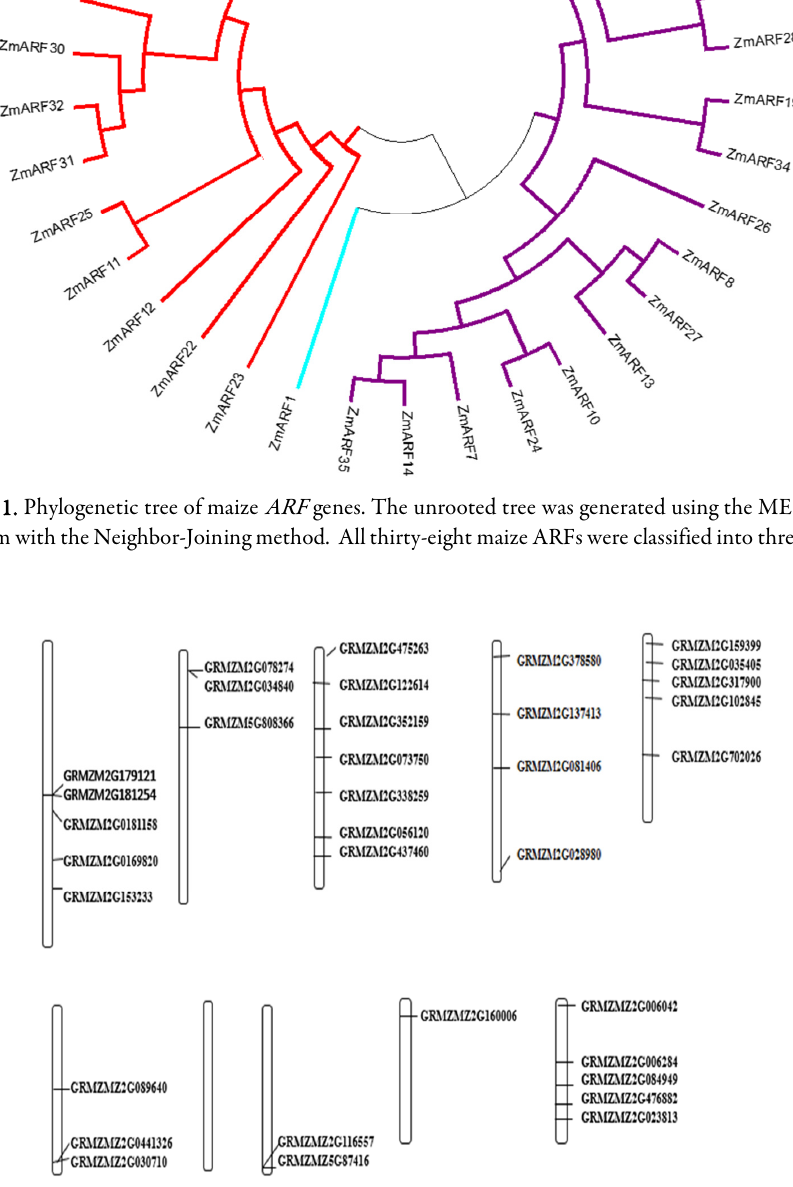
Figure 2. Chromosomal distribution and expansion patterns of maize ARF